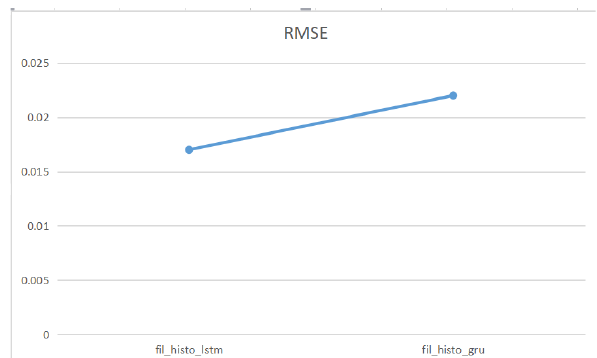
Fig. 11. Comparison between best performing LSTM and GRU